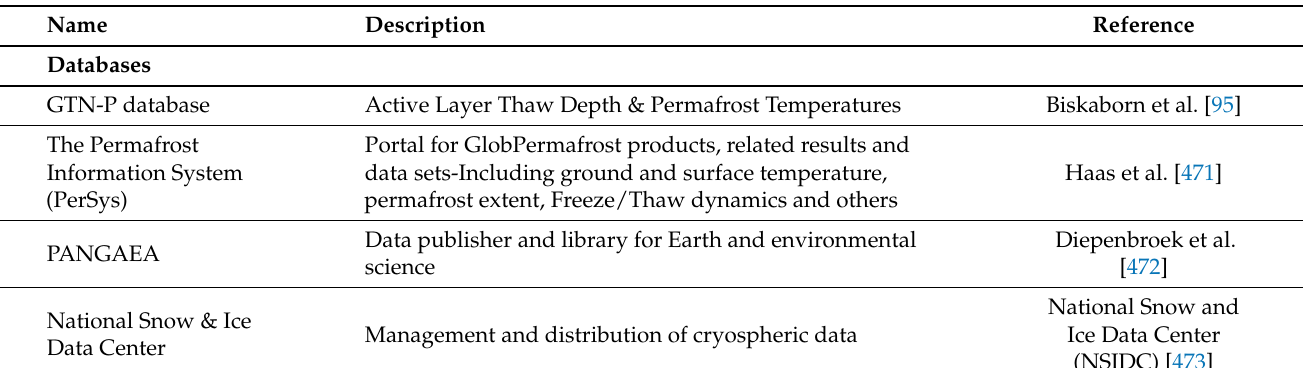
Table 5. Overview of a variety of permafrost related databases for openly available